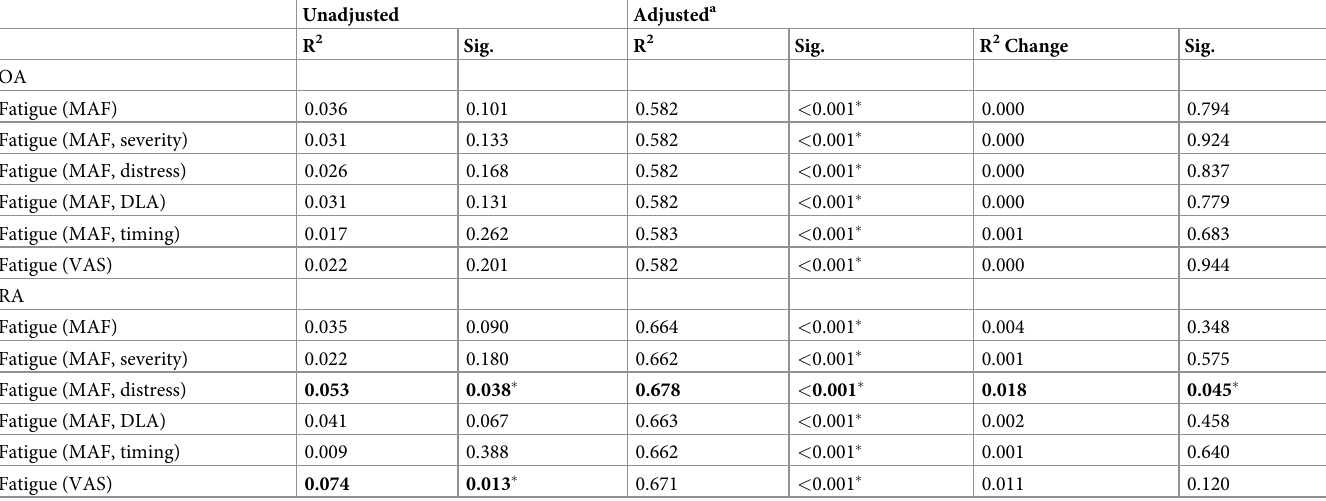
Table 3. Summary of the unadjusted and adjusted hierarchical multiple regression for appendicular muscle index and fatigue.